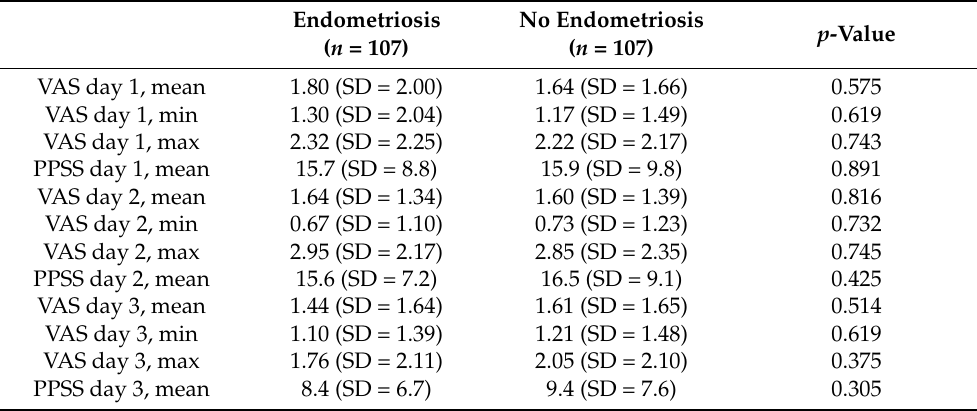
Table 5. Comparison of postoperative pain between groups with and without